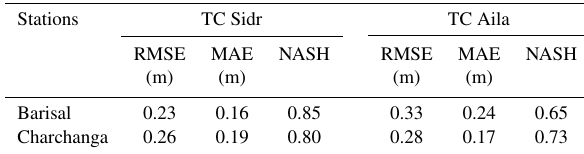
Table 4. Computed values of RMSE, MAE and Nash–Sutcliffe co- efficient for both TC Sidr and TC